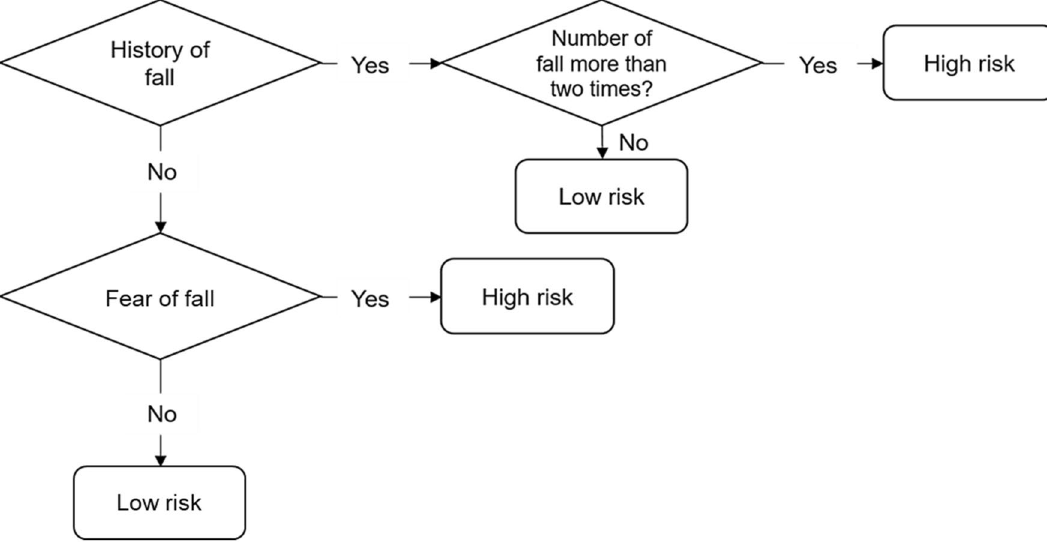
Figure 1. Fall levels definition. This metric was defined to classify the high and low fall risk based on the history of falls and fear of falls questionnaire 21